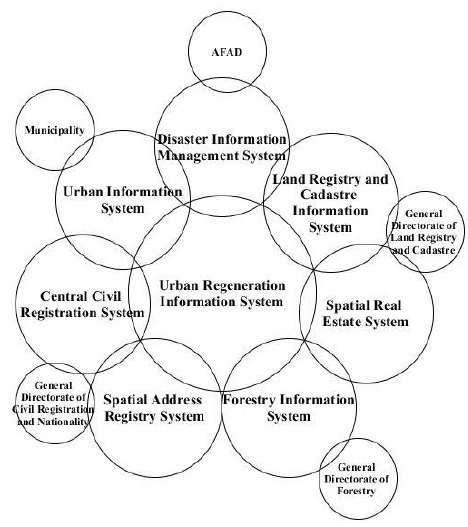
Figure 6. Urban Regeneration Database Integrated Components .